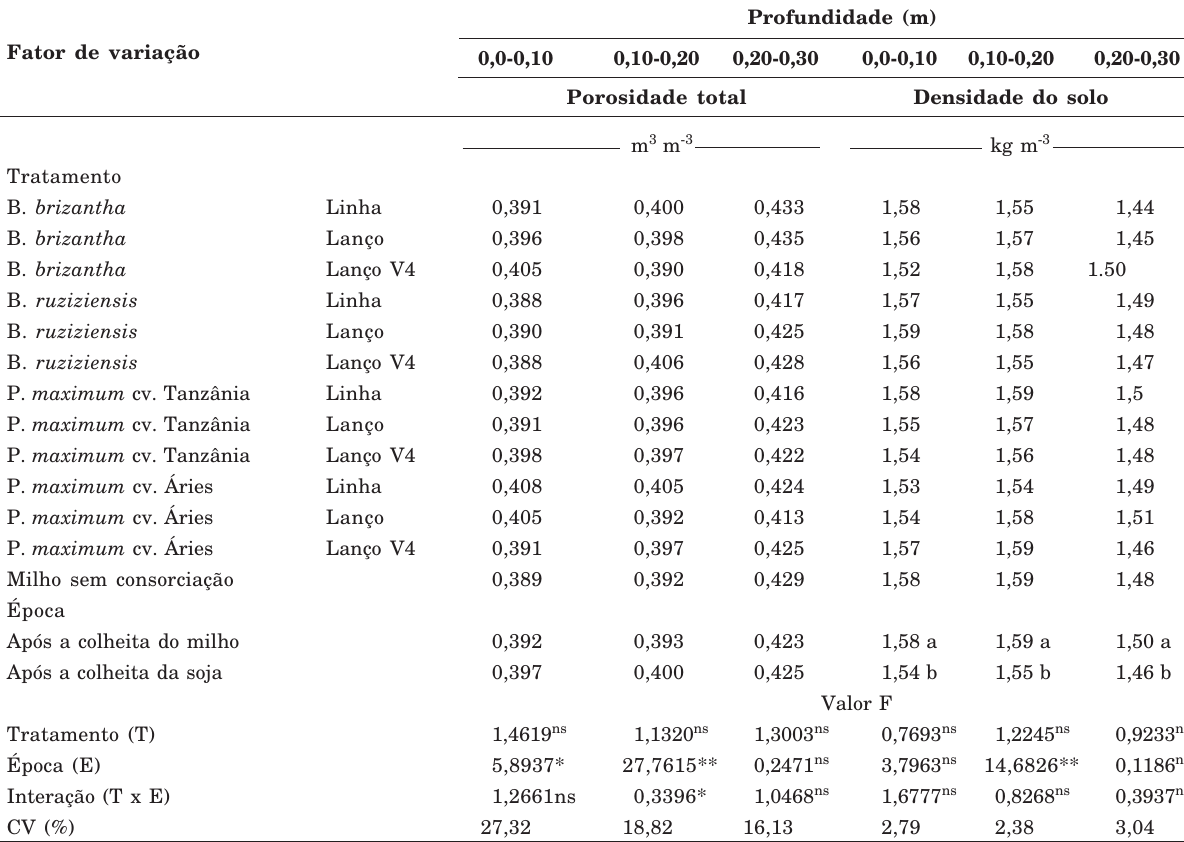
Quadro 9. Valores médios de porosidade total e densidade do solo avaliados nas camadas de 0,0-0,10,